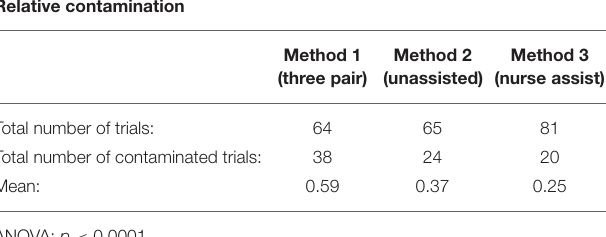
FIGURE 5 | An example of how airborne contamination can occur. The aberrant air flow created with forceful entry of the hand into a glove can lead to airborne spread proximally. TABLE 2 | Absolute contamination pertains to any type of outer surface Glitterbug TM contamination present post-glove change. Absolute contamination